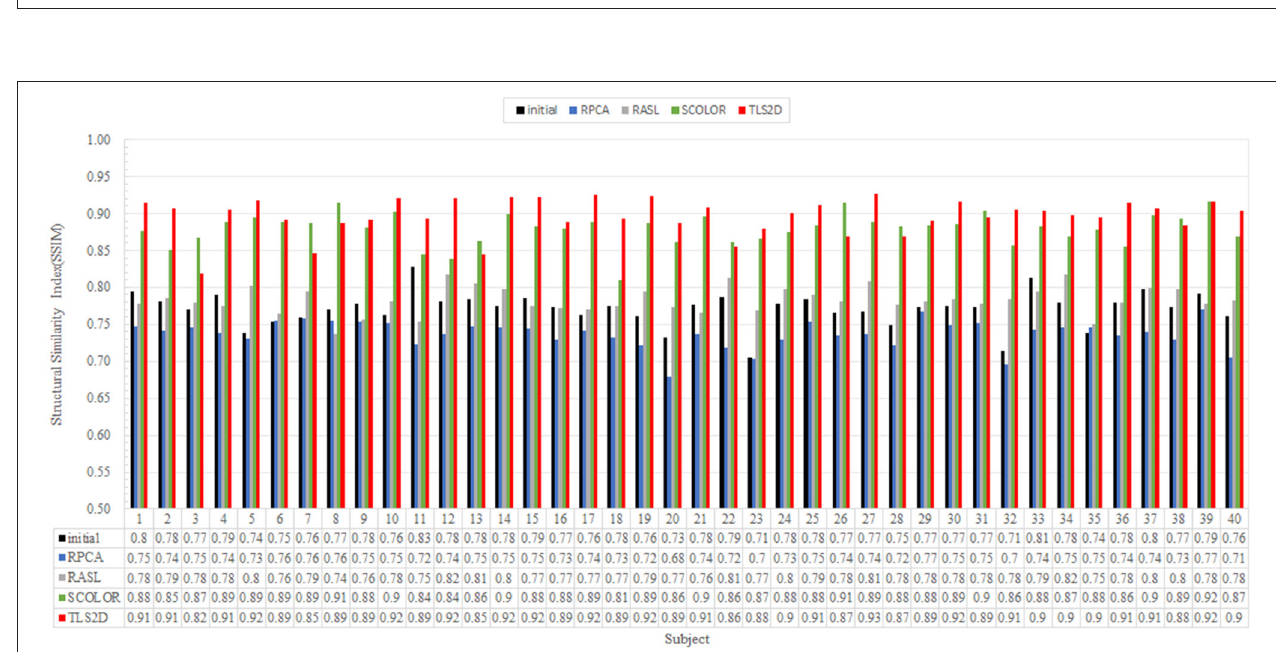
FIGURE 5 | The structural similarity index (SSIM) between each of the original MR images and the corresponding recovered images by different methods. The “Initial” indicates the SSIM between the synthetic tumor images and the corresponding original images.